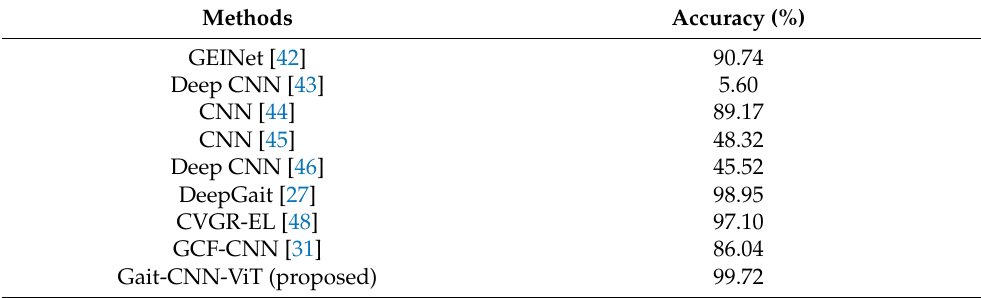
Table 5. Comparison results on the OU-LP